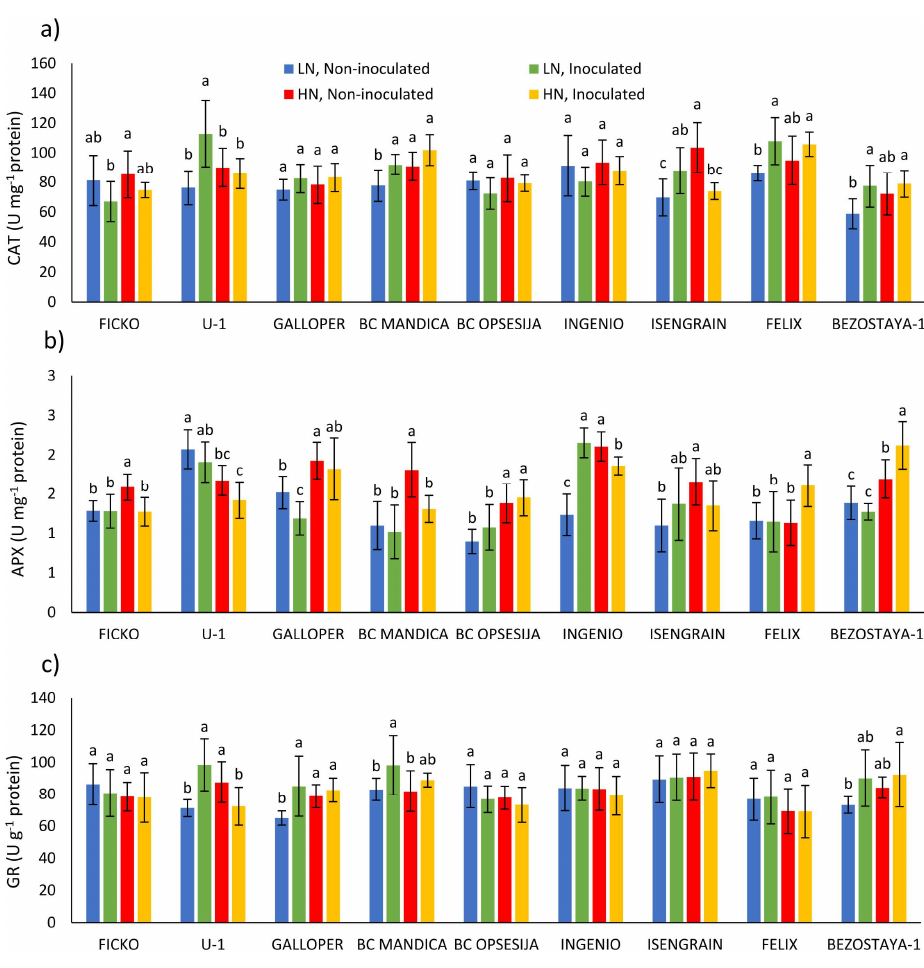
Figure 2. Antioxidant enzyme activity: catalase (CAT; ( a )), ascorbate peroxidase (APX; ( b )), and glutathione reductase (GR; ( c )) in spikes of nine wheat varieties under different nitrogen (LN—low nitrogen; HN—high nitrogen) and Fusarium (non-inoculated and inoculated) treatments. Values are means of six replicates ± standard deviation (SD). Different letters above the bars indicate significant differences according to Fisher’s LSD test ( p ≤ 0.05) among different treatments in each variety